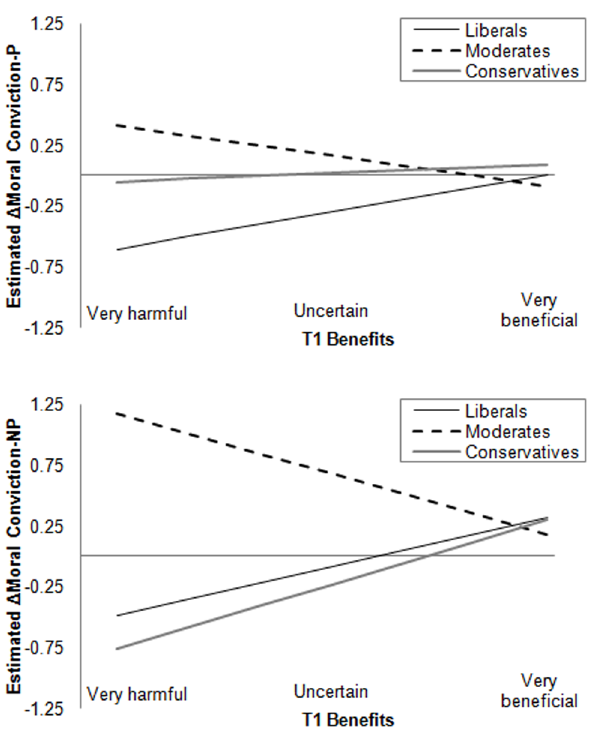
Figure 6. Estimated change in moral conviction at levels of time 1 benefits for liberals, moderates, and conservatives. Note . All estimates based on the null multi-group model (see Table